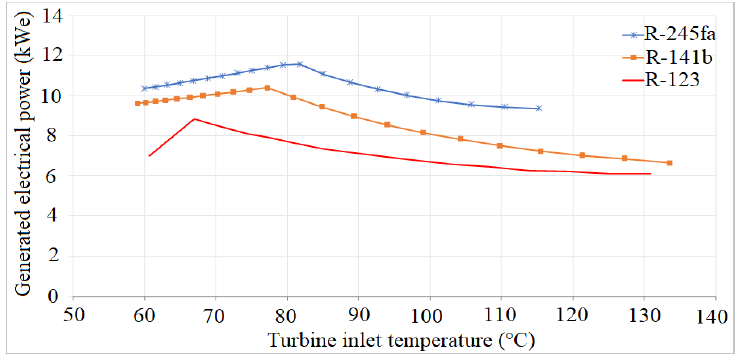
Figure 7. Illustrates the behavior of the electric power generated by the Organic Rankine Cycle for different working